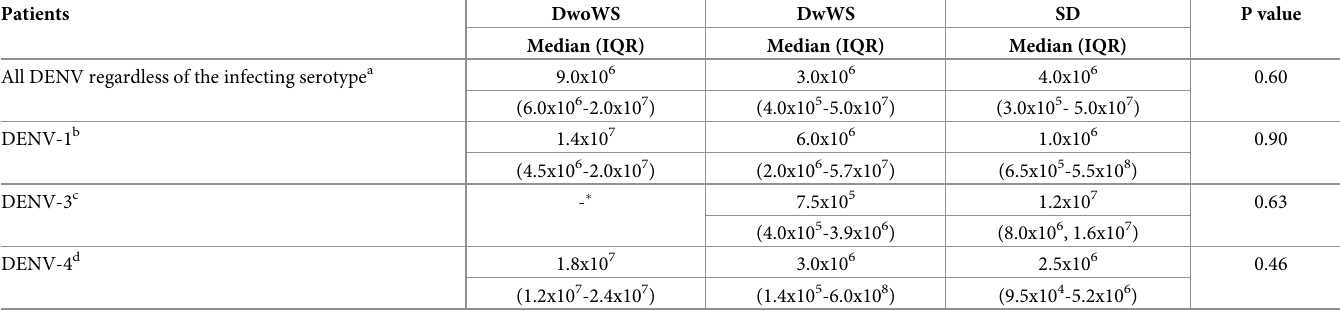
Phylogenetic trees analysis was performed based on the nucleotide sequences coding on the region of envelope protein gene. The nucleotide sequences were read by next-generation Table 3. Comparison of viremia level according to severity of infection among all DENV